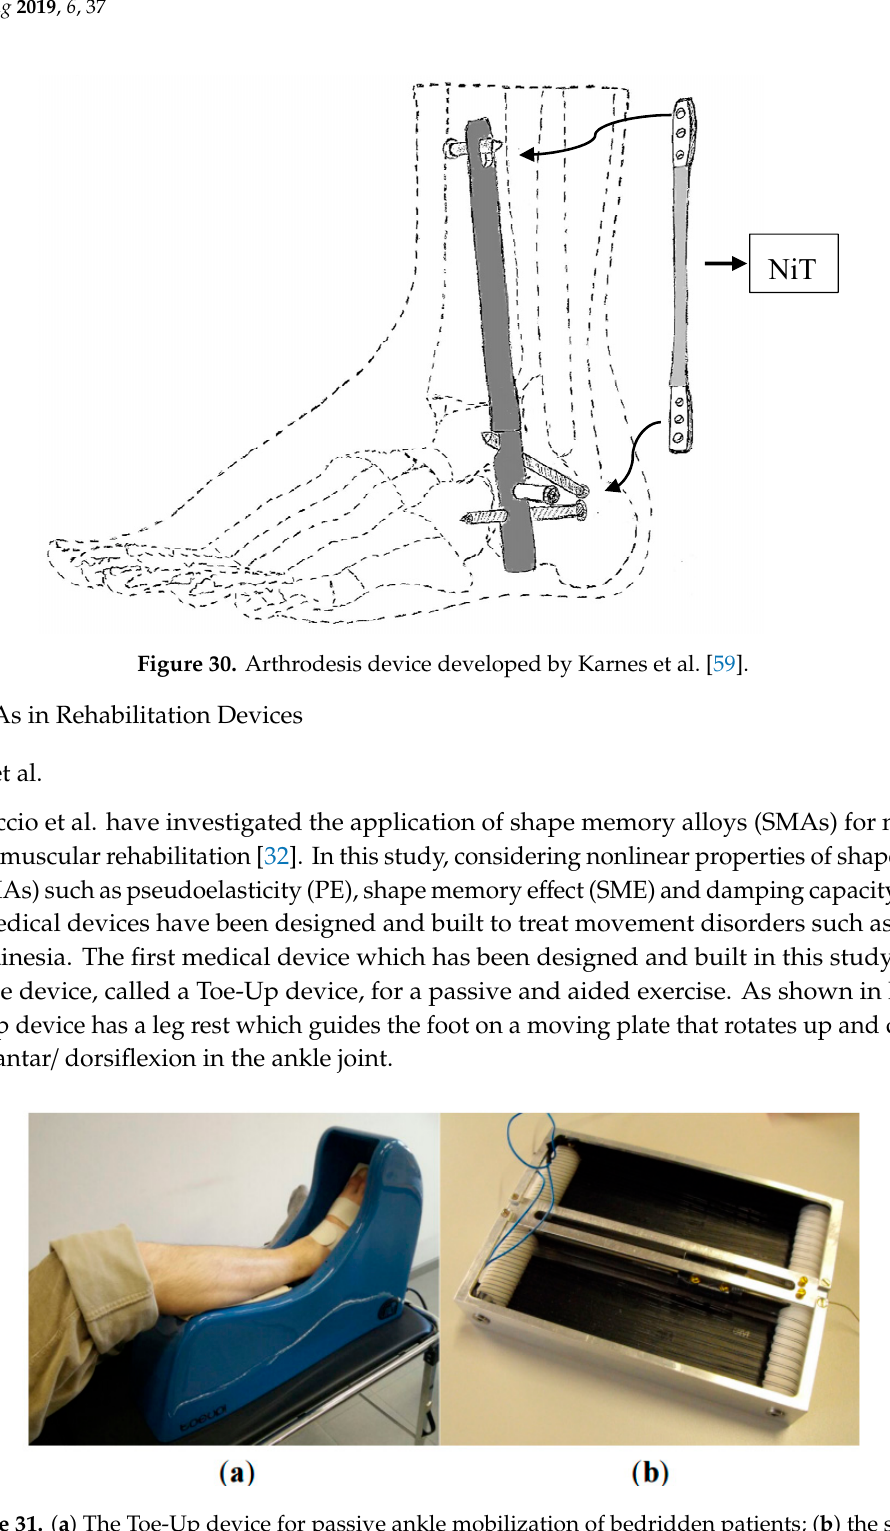
Figure 31. ( a ) The Toe-Up device for passive ankle mobilization of bedridden patients; ( b ) the shape memory alloy (SMA) actuator used to generate ankle dorsiflexion [32].